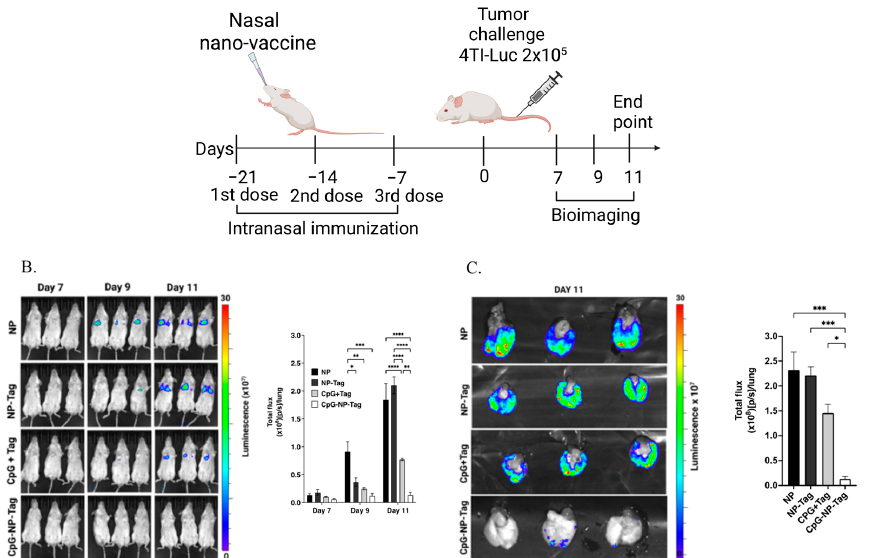
Figure 2. Nasal nano-vaccine immunization increases protection against experimental lung metas- tasis of 4T1 breast tumor cells. ( A ) Schematic of the study timeline for vaccine dosing followed by tumor challenge and bioluminescence imaging in BALB/C mice. ( B ) Whole mouse bioluminescence images (left) and quantification of luminescence signal intensity (right) 7-, 9-, and 11-days post tu- mor challenge. ( C ) Excised lungs’ bioluminescence images (left) and quantification of luminescence signal intensity (right) day 11 post tumor challenge. One-way ANOVA followed by Tukey’s multi- ple comparison tests. **** p < 0.0001, *** p < 0.001, ** p < 0.01, * p < 0.05.